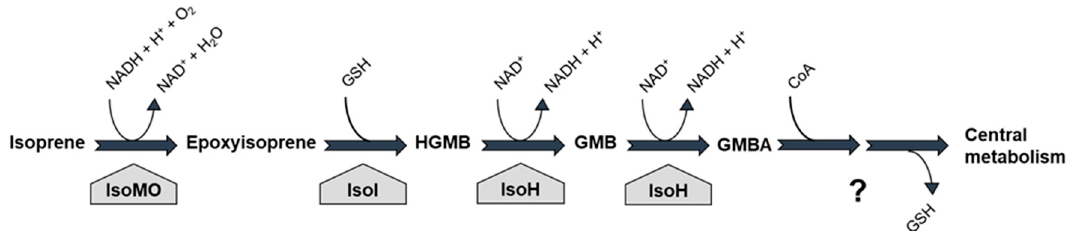
Figure 1 . Isoprene degradation pathway in the model isoprene-utilising bacterium Rhodococcus sp. AD45. Enzymes: IsoMO, isoprene monooxygenase; IsoI, glutathione- S -transferase; IsoH, dehydrogenase; HGMB, 1-hydroxy-2-glutathionyl-2-methyl-3-butene; GMB, 2-glutathionyl-2-methyl-3-butenal; GMBA, 2-glutathionyl-2-methyl-3-butenoic acid; GSH, reduced glutathione. The question mark indicates uncertainty in the details of the catabolic pathway from GMBA.